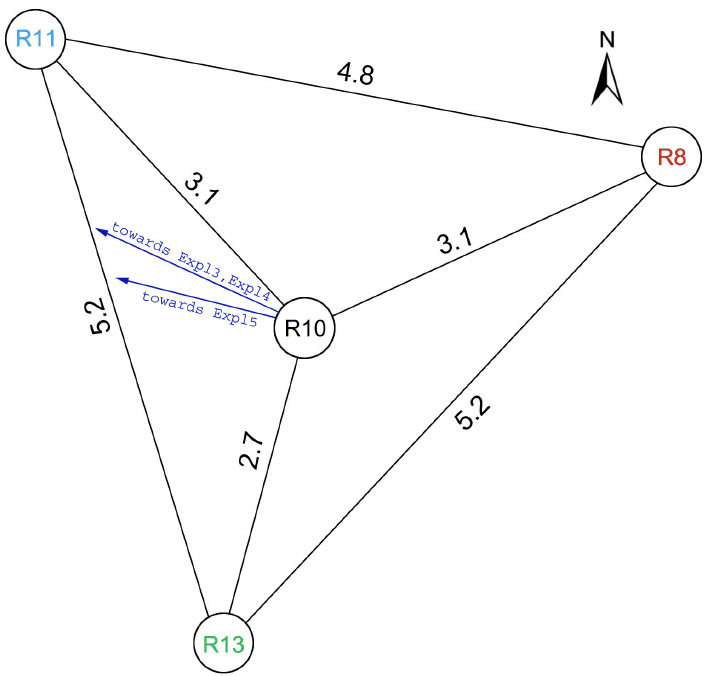
Figure 7. A detailed layout the Rotaphone-CY array. Numbers indicate the distance in meters between centers of the